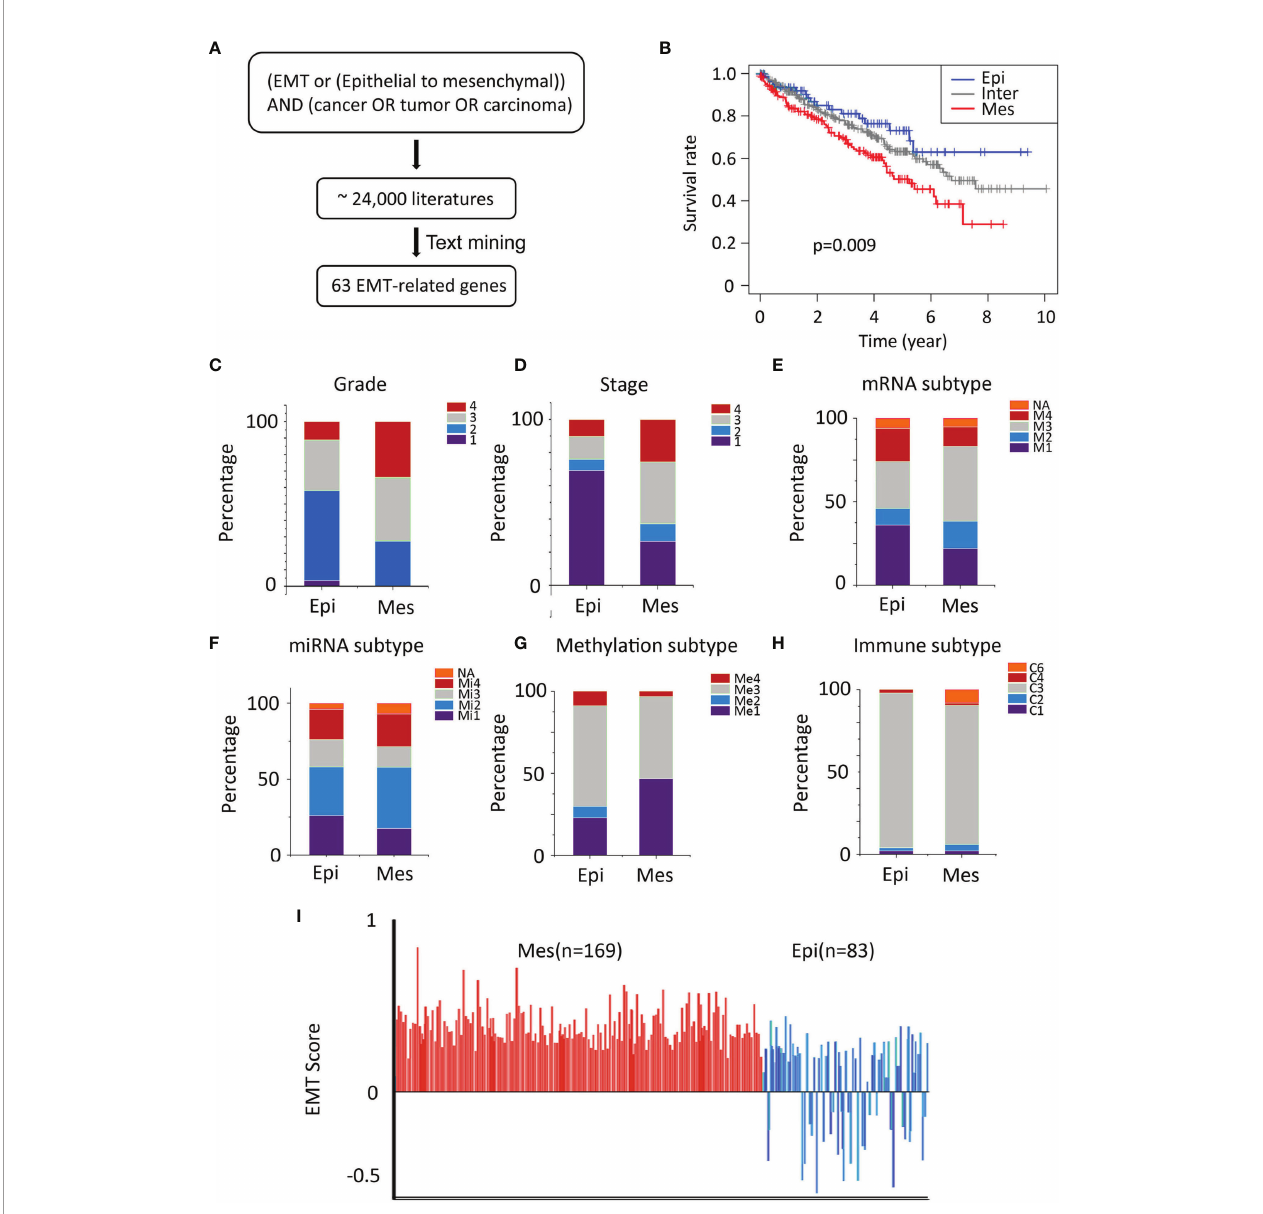
FIGURE 1 | Characteristics of TCGA cohort. (A) Text-mining literature abstracts associated with EMT from the PubMed database identi fi ed 63 EMT-related genes. (B) Overall survival analysis for sample clusters. (C, D) General TNM and grade characteristics of patients of the two clusters (left and middle). (E – G) Signi fi cant differences in mRNA-based, miRNA-based, and methylation classi fi cation were identi fi ed for both the Epi and Mes clusters. (H) The proportion of samples belonging to each immune subtype in two clusters. (I) Plot of EMT scores (mean ± SEM; y-axis) of in samples. EMT score nearer to +1.0 is more mesenchymal-like (Mes), whereas EMT score nearer to -1.0 is more epithelial-like (Epi), Epi, blue; Mes,